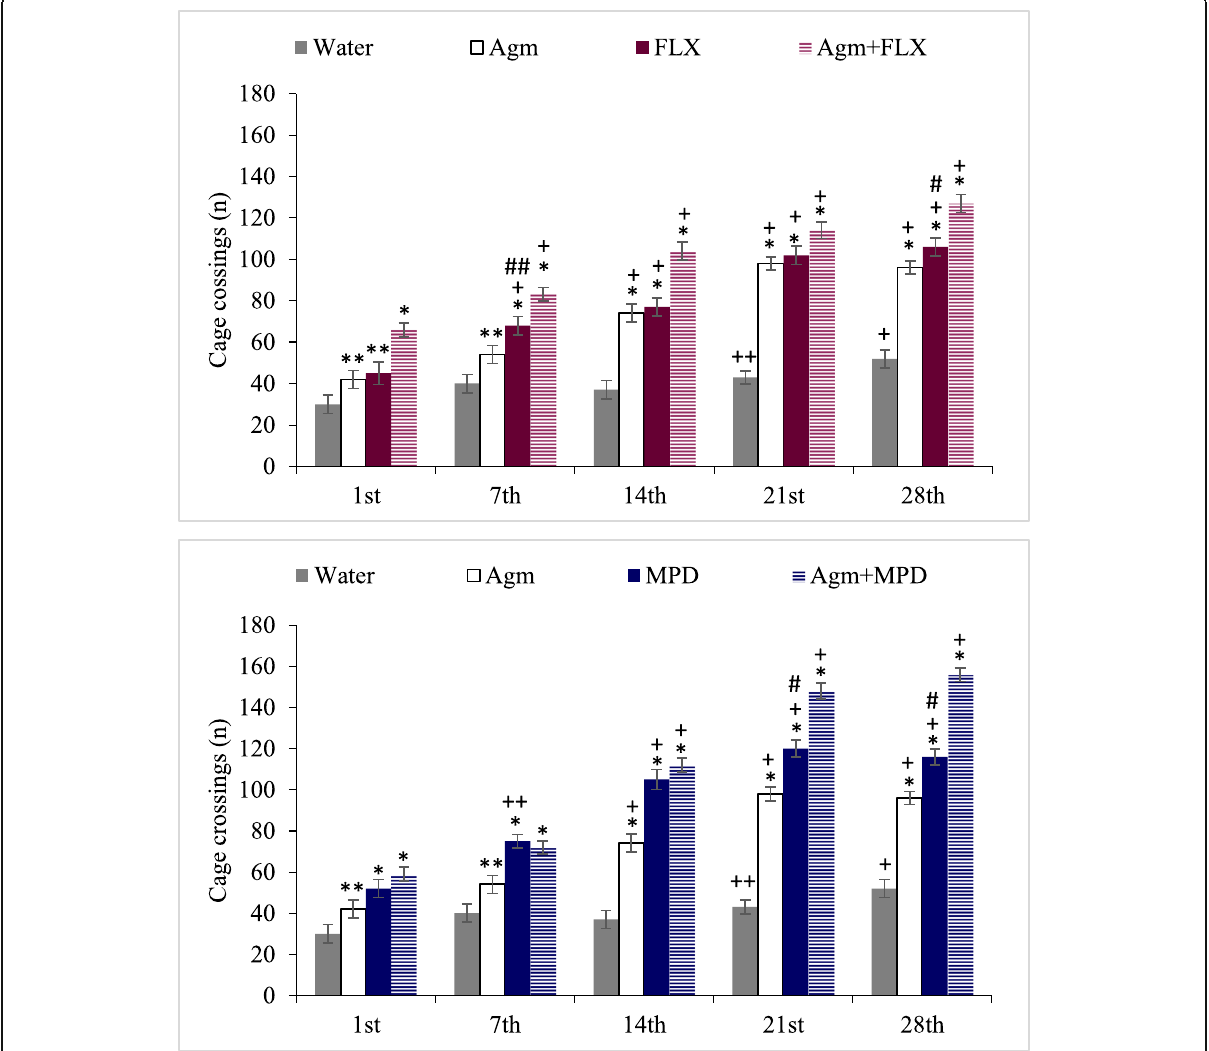
Fig. 7 Activity box test: values are expressed as means ± SD ( n =6). Significant differences by Newman-Keuls test: * p <0.01, ** p <0.05 from water- treated control group to drug-treated groups. + p <0.01, ++ p <0.05 from drug ’ s 1st administration. # p <0.01, ## p <0.05 from AGM-treated animals